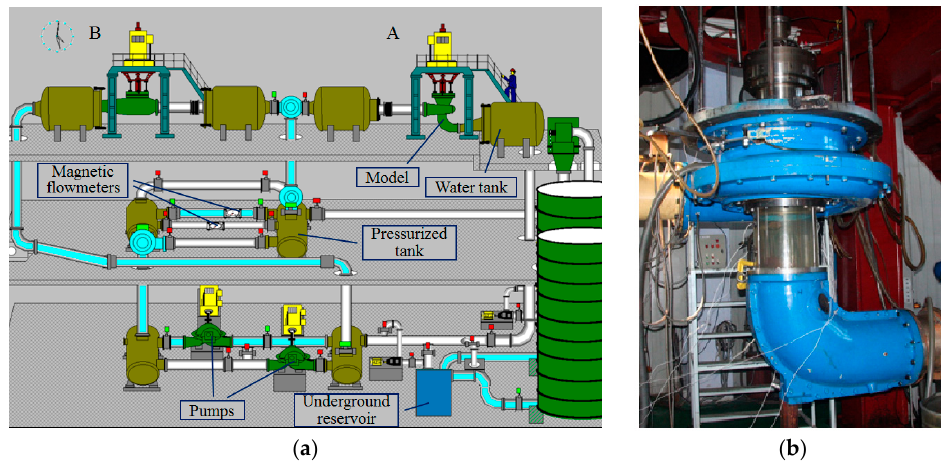
Figure 2. International Electrotechnical Commission (IEC) standard test rig. ( a ) Schematic diagram; and ( b ) test section. Table 2. Characteristics of test rig performance and pressure sensors.